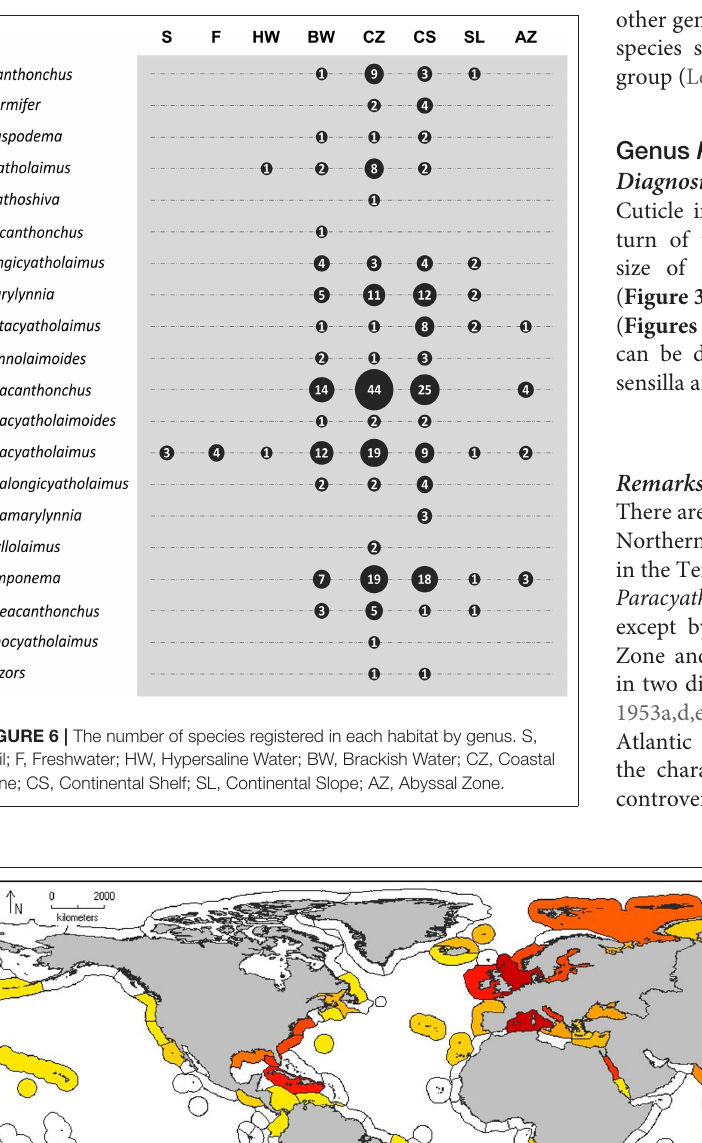
Frontiers in Marine Science |